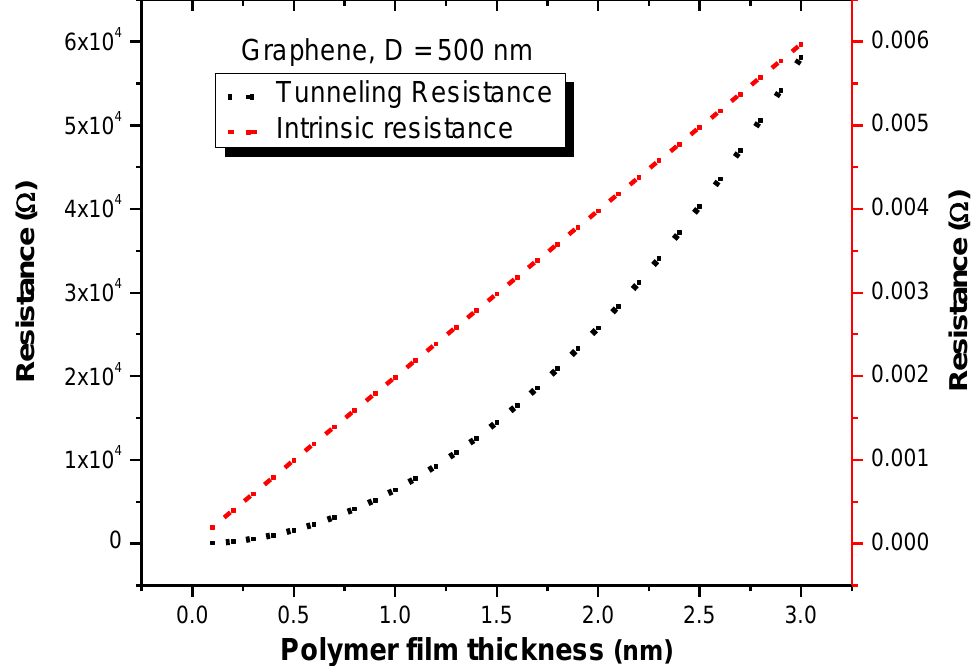
Figure 5. Intrinsic and tunneling resistances as a function of insulation thickness.